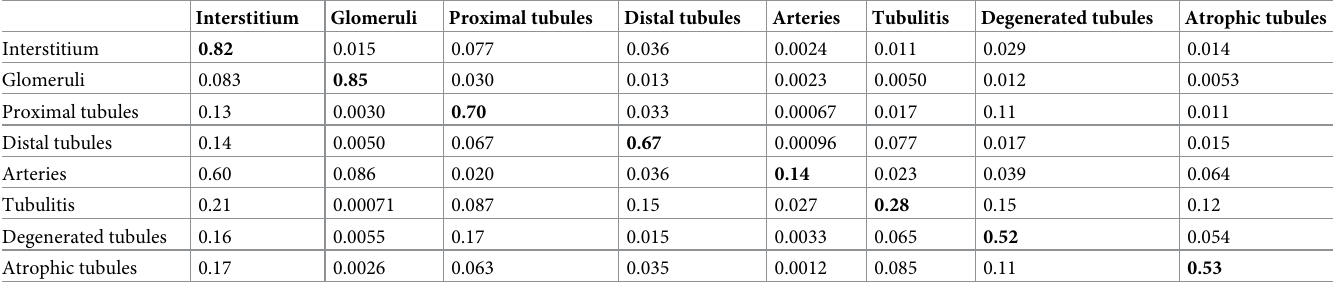
Table 5. Confusion matrix for eight-class segmentation using